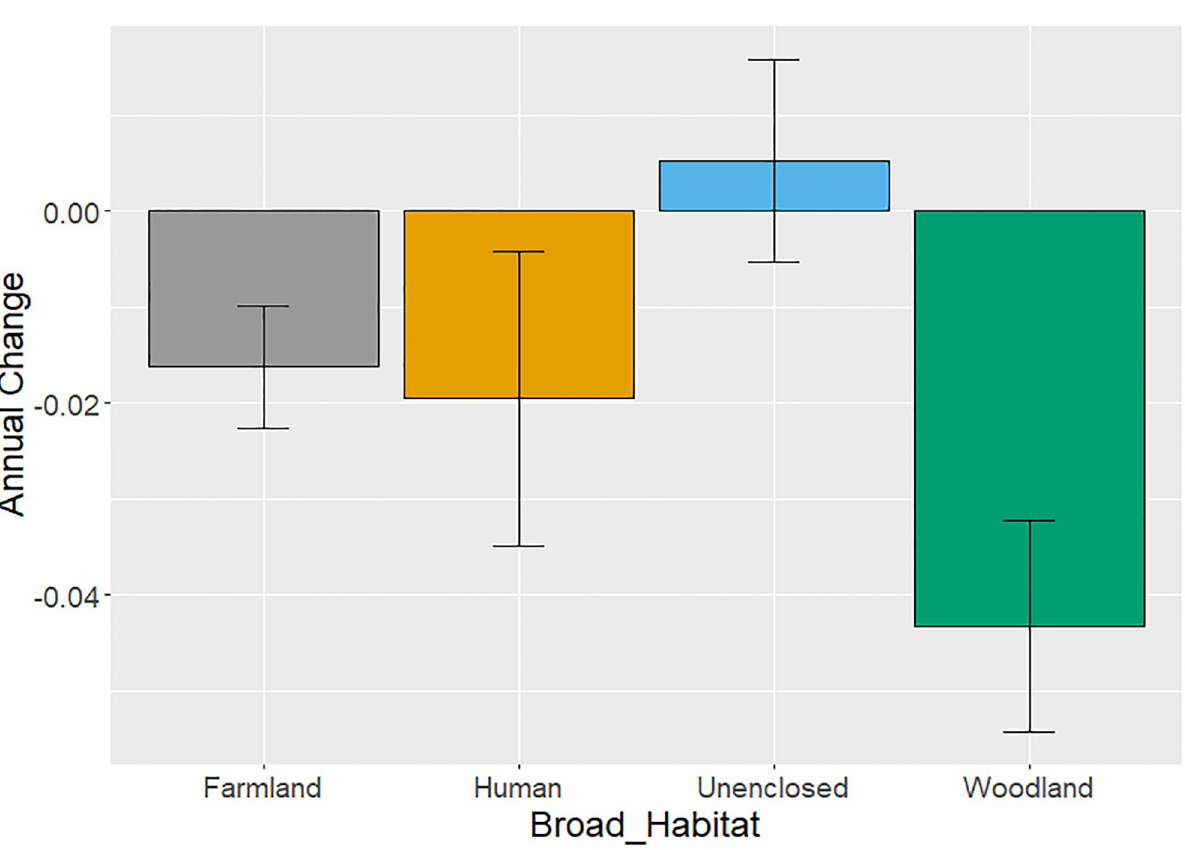
Fig 6. Broad_Habitat specific trends in earthworm abundance. Habitat specific earthworm abundance trends using unweighted Model 3 including the interaction with Year and Broad_Habitat. See Table 5 for estimates (the stars represent significance from zero: * < 0.01, ** < 0.001, *** <